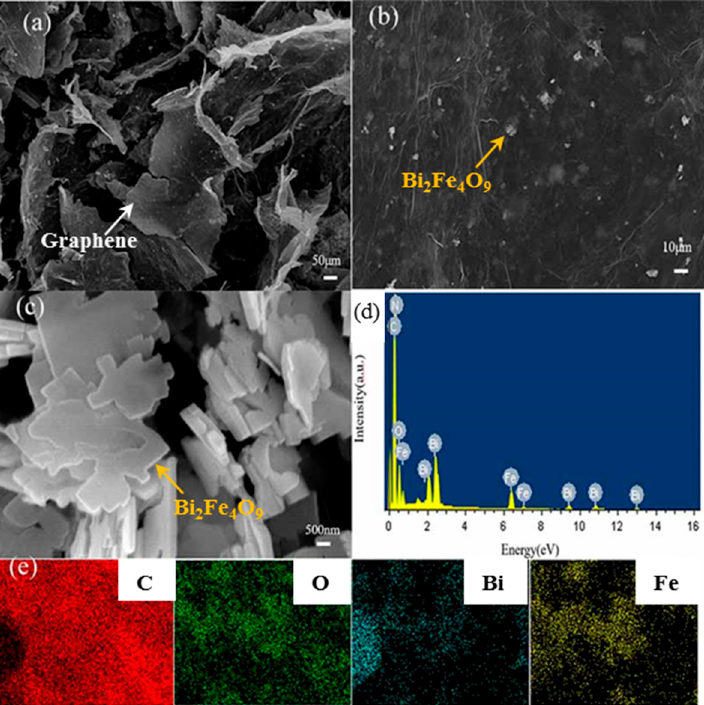
Figure 2. ( a – c ) SEM images, ( d ) EDX spectra and ( e ) mapping images of the prepared Bi 2 Fe 4 O 9 /GA composite.